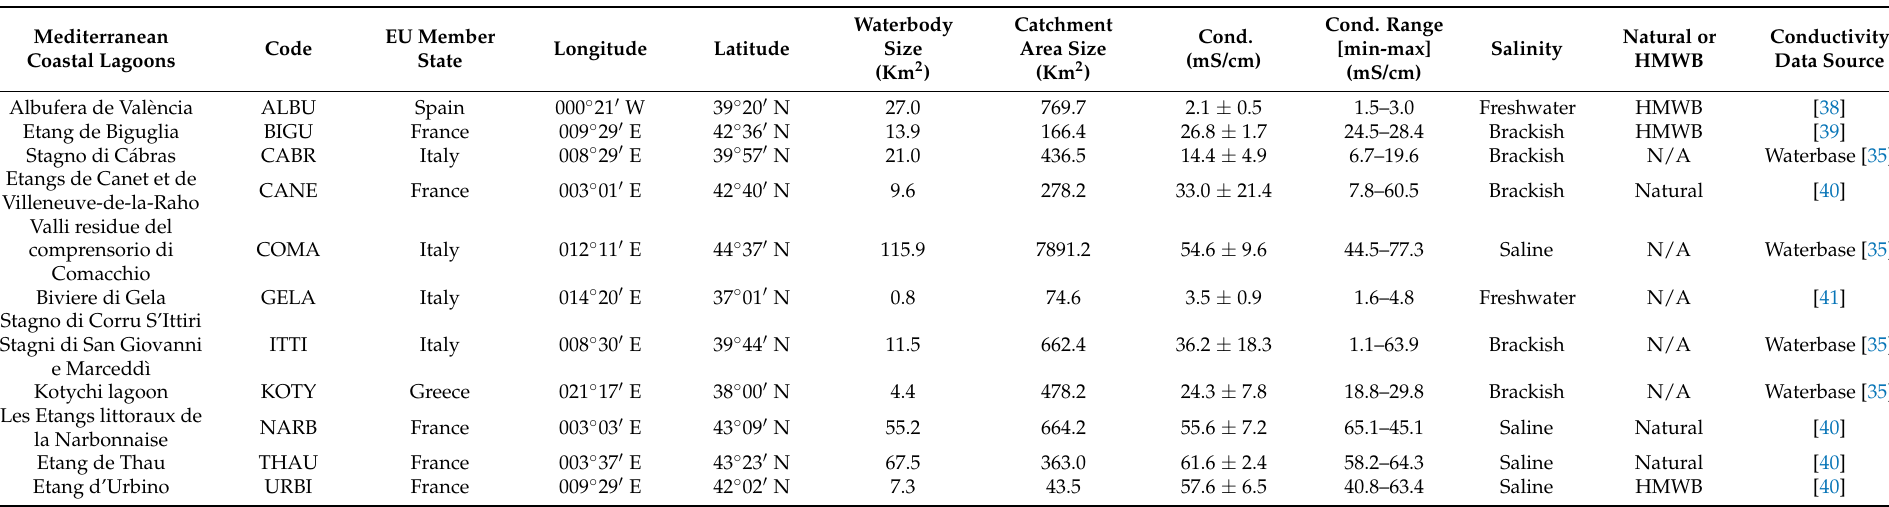
Table 1. Location, morphological features, water electrical conductivity (Cond.) and classification according to salinity, and degree of affection of the sites studied for the determination of the pollution pressures. Conductivity is shown as the average ± standard deviation, as well as the maximum and minimum values (range) given by the data sources. HMWB = heavily modified water